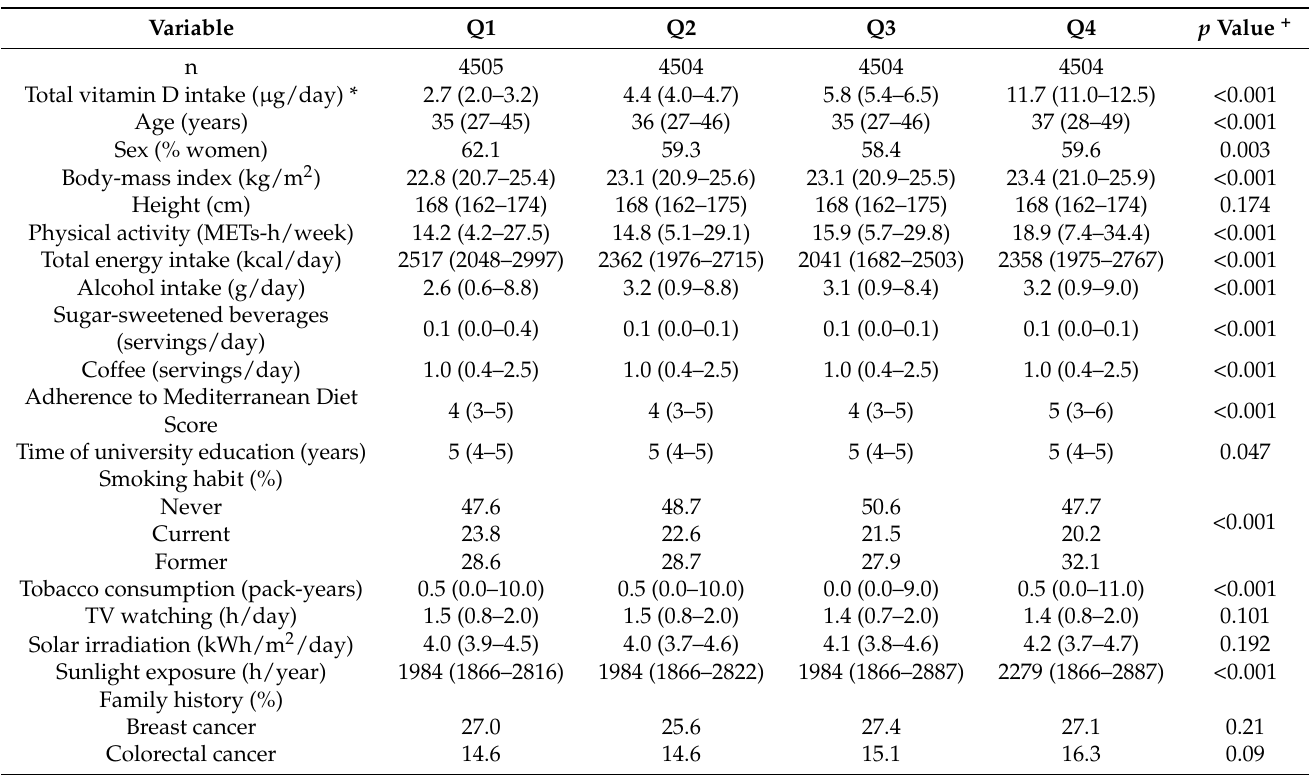
Table 1. Baseline characteristics of participants in the SUN Project, according to energy-adjusted quartiles of vitamin D (diet and